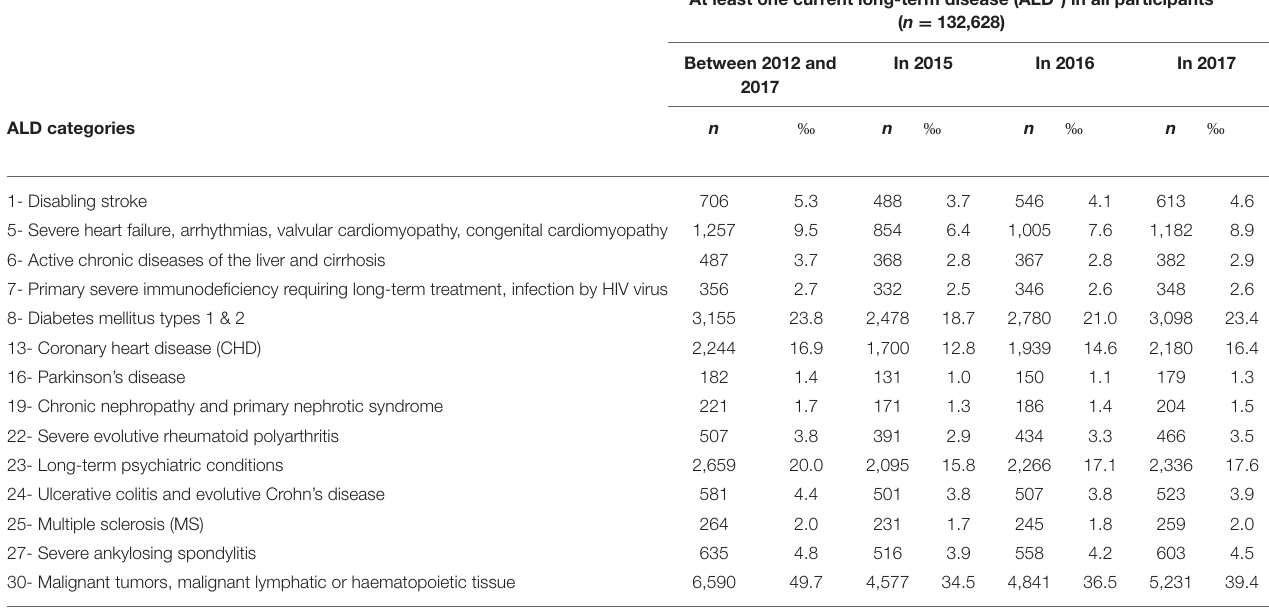
TABLE 1 | Crude prevalence of major health outcomes during the 2012–2017 period in 132,628